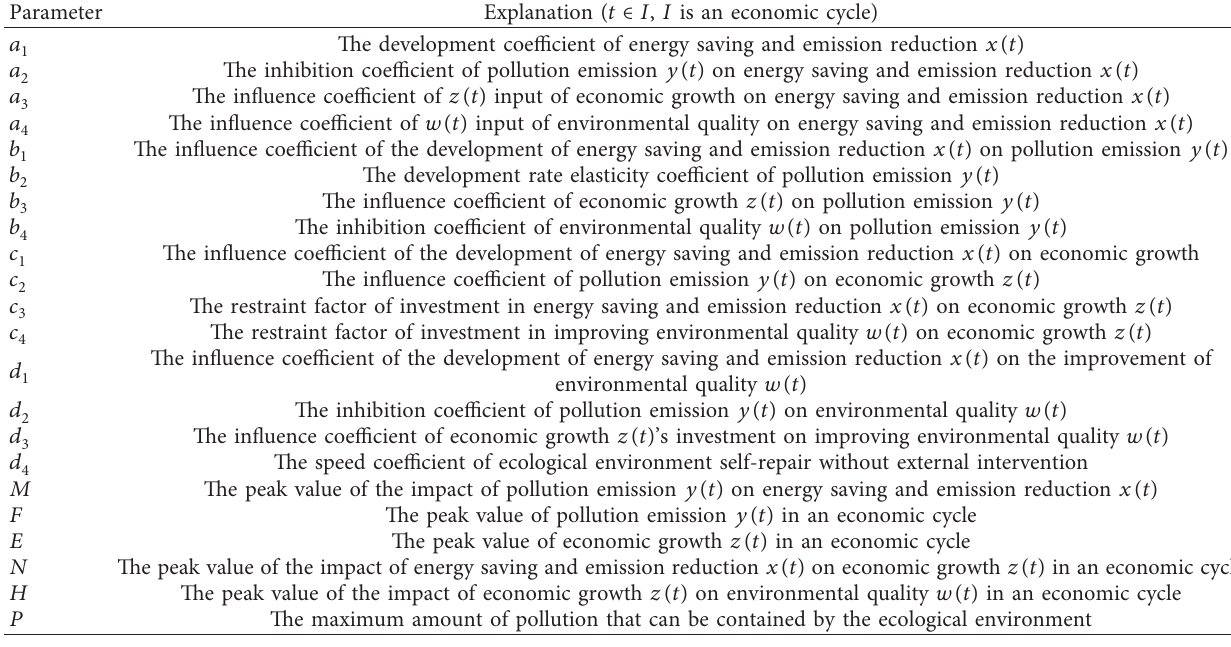
Table 1: The specific meanings of each parameter are explained.